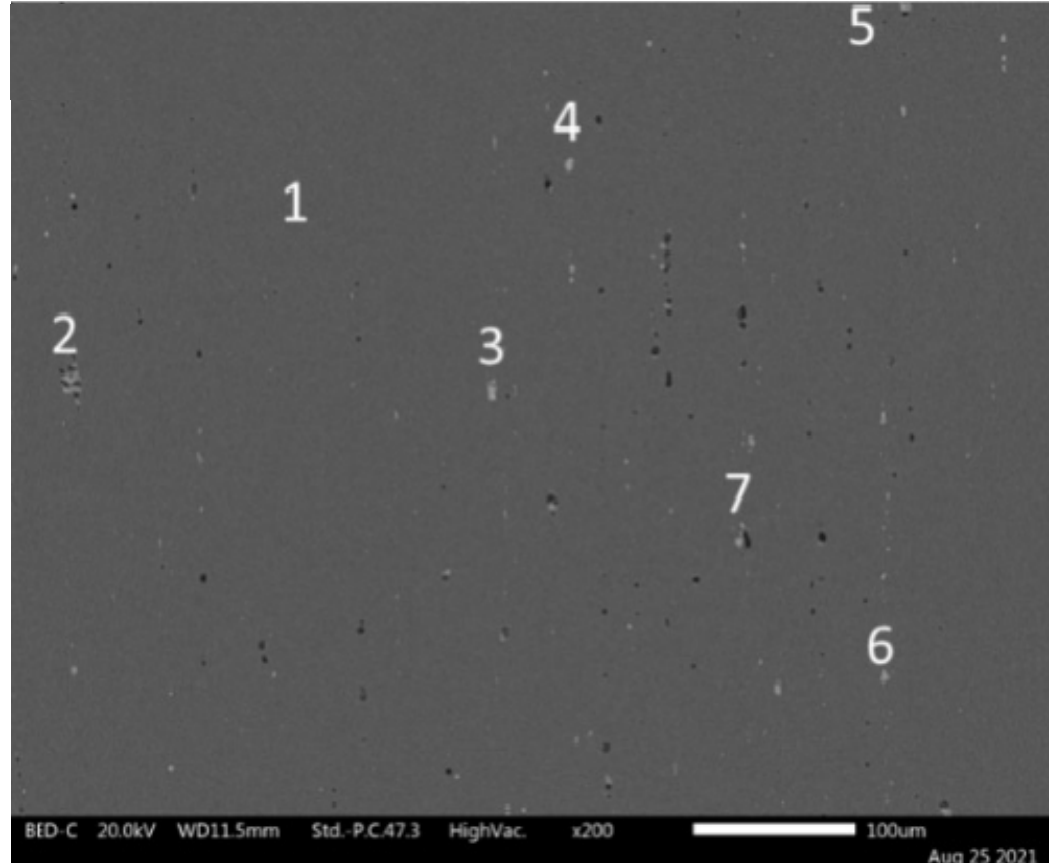
Figure 7. The solid-solution microstructure of 2A97. Table 3. The EDS results of solid-solution microstructure (wt.%).